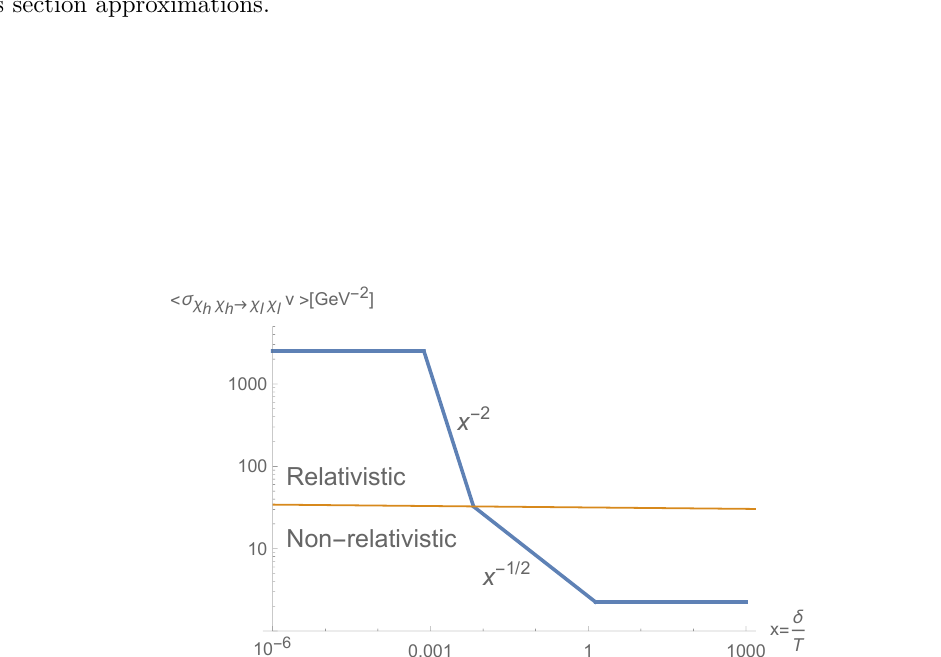
Figure 16 . Plot of the approximation for the cross section times velocity for the scattering χ h χ h → χ l χ l for masses m χ The dashed black line correspond to full expression for the cross section, the colored lines are the cross section approximations.